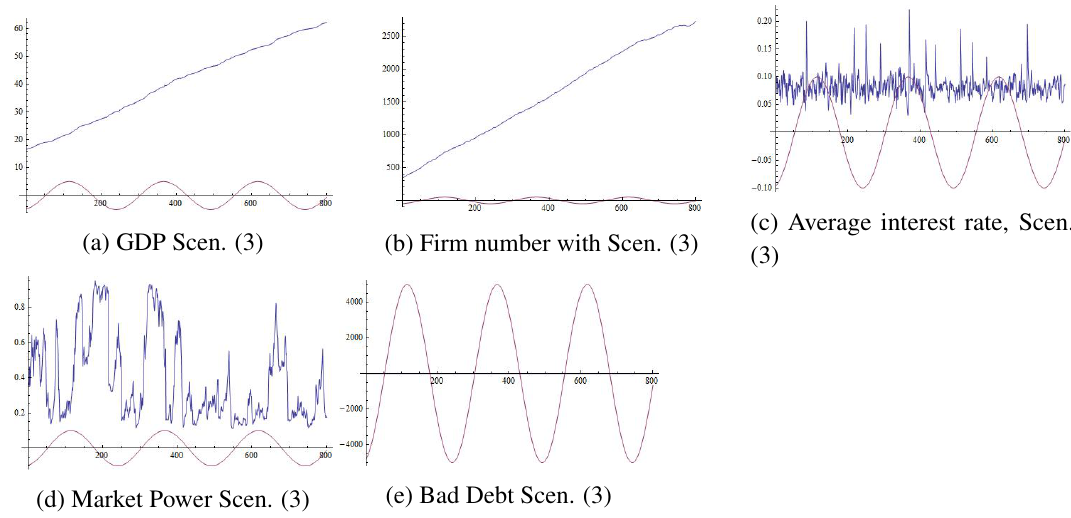
Figure 12: Stock prices with persistent